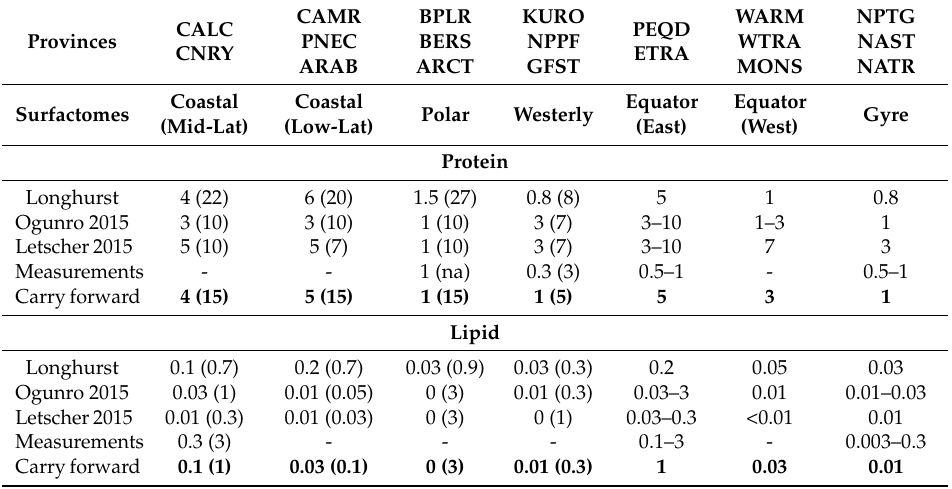
A summary of community knowledge for global concentration distributions of the macromolecules ( µ M dissolved carbon). Background levels are non-parenthetical, and are followed, where relevant, by (bloom) values. Tropical concentrations vary little over an annual cycle. Province definitions are taken from the Longhurst ecological geographies, then combined to optimize the limited individual compound data (our “surfactomes” e.g., coastal middle latitudes). Ecodynamic models here have previously been applied in two divergent contexts—studies respectively of Arctic methane cycling leading to dynamic global macromolecular distributions, or else dissolved organic elemental ratios (Ogunro, then Letscher). Observations are transferred directly from the validation list for the first code, summarizing three dozen chemically-resolved